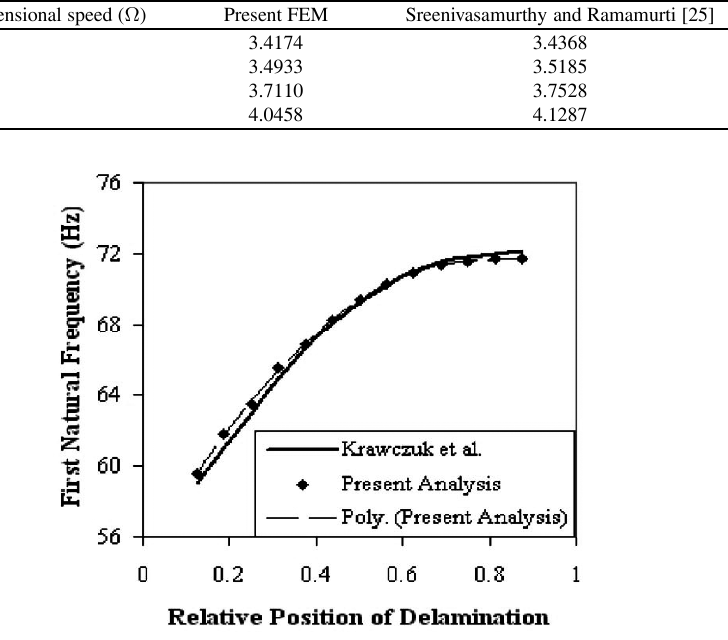
Fig. 3. In fl uence of the relative position of delamination on the fi rst natural frequency of the composite cantilever beam (Krawczuk et al.